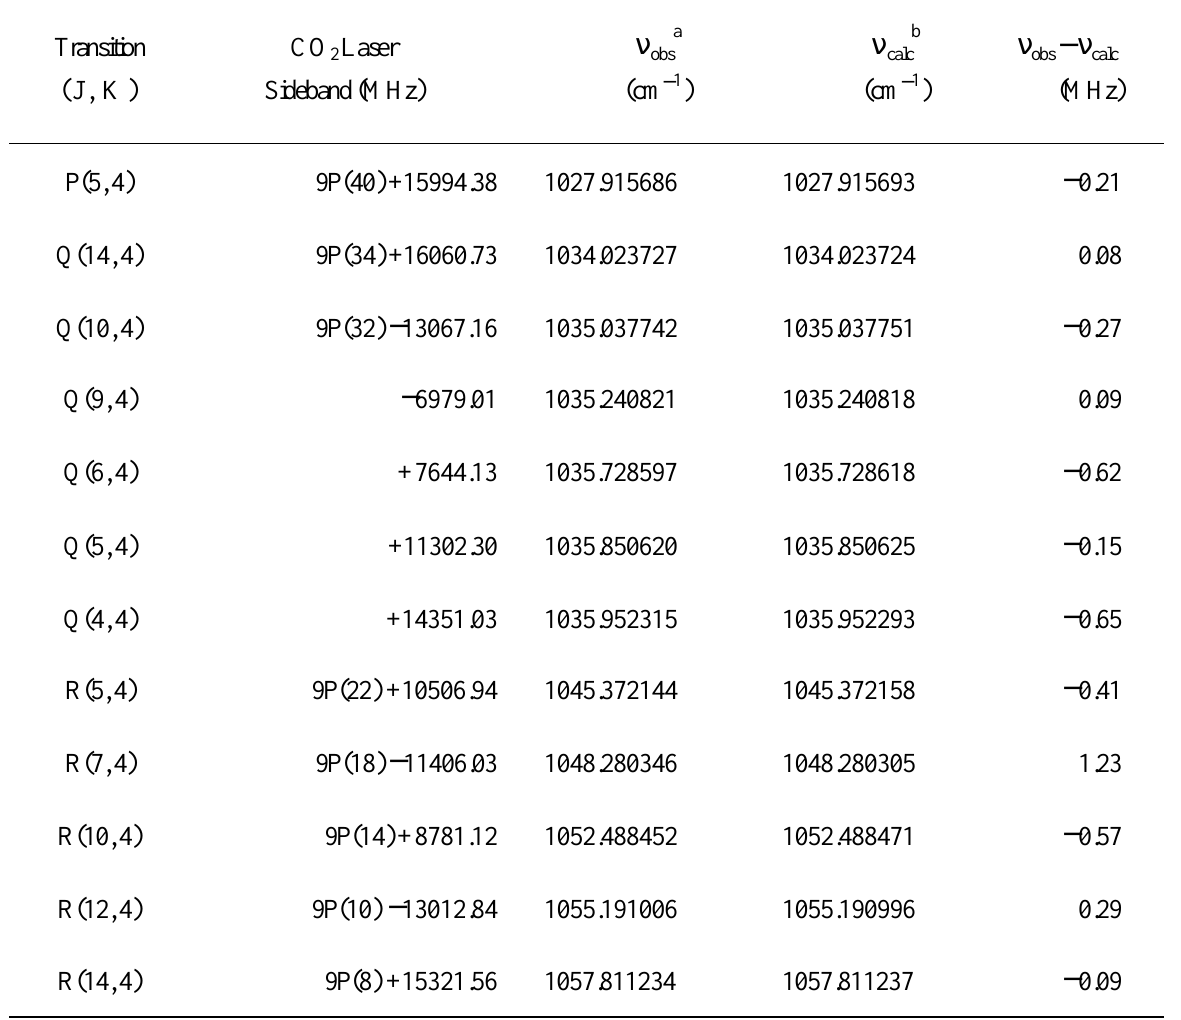
Table 1. Observed Transitions for the (2,A, 4) Sequence in the C - O